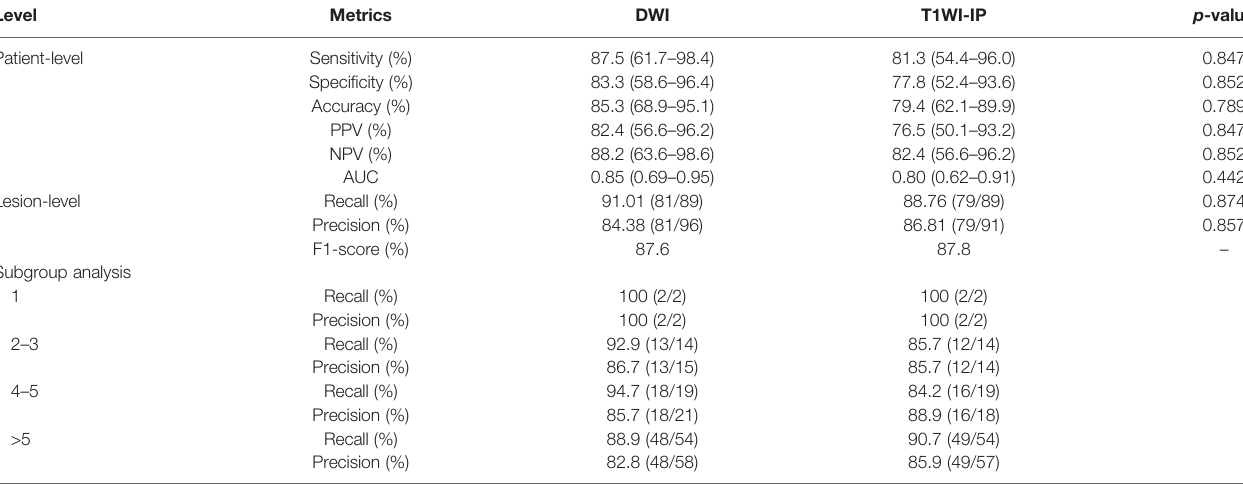
TABLE 5 | Detection accuracy of bone metastases at patient and lesion